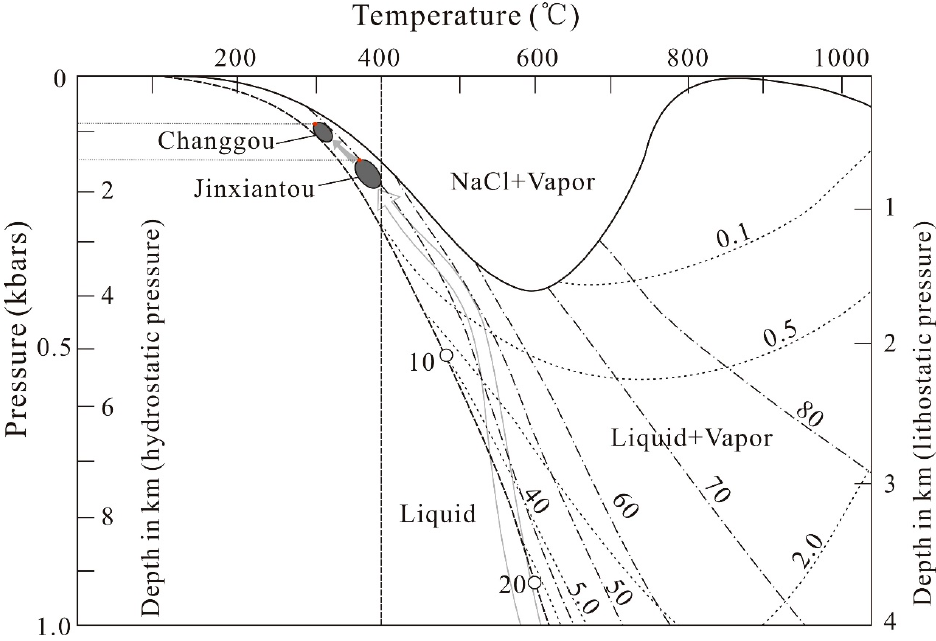
Figure 11. Pressure–temperature (P–T) diagram for the H 2 O–NaCl system in the Changgou and Jinxiantou deposit (adapted from Redmond et al. [41], Fournier [46], and Hedenquist et al. [44]). The brittle ductile transition zone lies at about 400 °C [46]. The brittle plastic transition zone lies at about 400 °C [44]. The critical curve is shown by the dashed thick line with labels for 10 mas. %, 20 mas. %, and 30 mas. % NaCl equivalent. fluids. Dot dashed lines are contours of constant mas. % NaCl dissolved in brine (boiling-point curves) with values for 40, 50, 60, 70 and 80 wt. % NaCl equivalent. Dotted lines are contours of constant mas. percent NaCl dissolved in vapor (condensation curves) with values for 0.1 mas. %, 0.5 mas. %, 2.0 mas. %, and 5.0 mas. % NaCl equivalent, respectively.